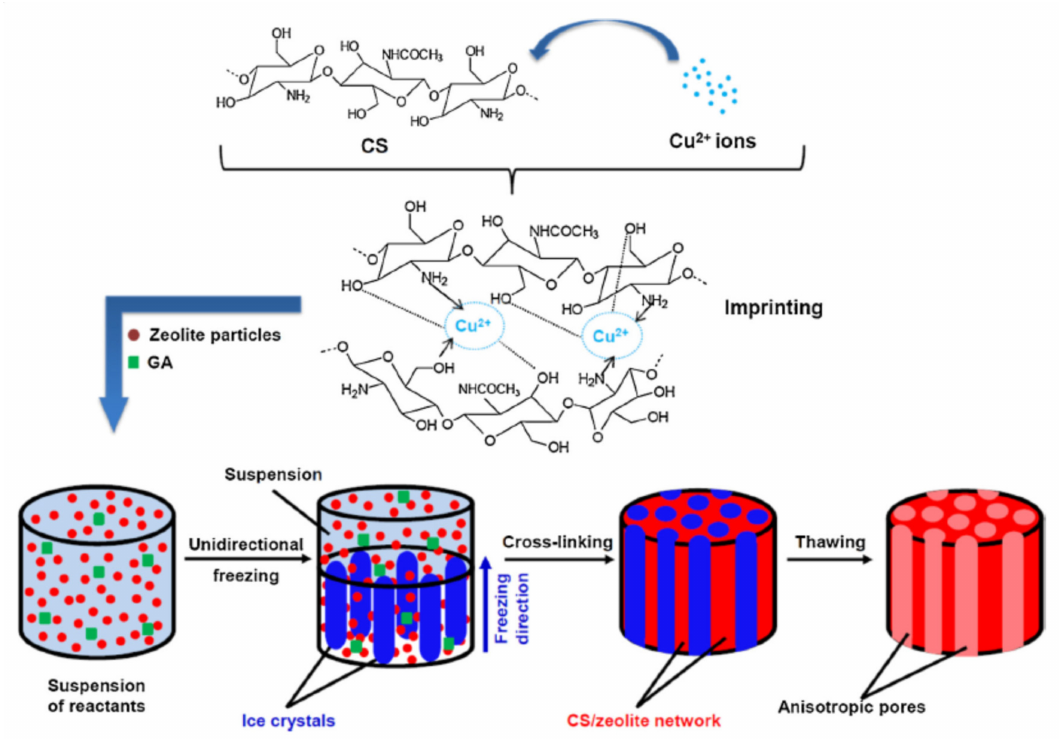
Figure 12. Schematic representation of composite cryogels based on CS and zeolites using a combination of ion-imprinting and freezing methodology (reprintedwith permission from ref.